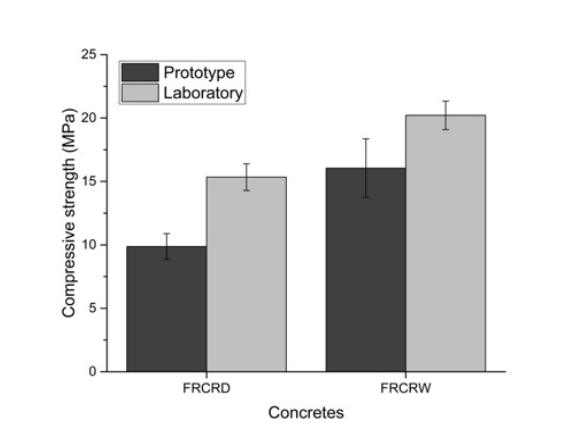
Figure 9. Comparison between the compressive strength of the blocks produced in the laboratory and in the field.